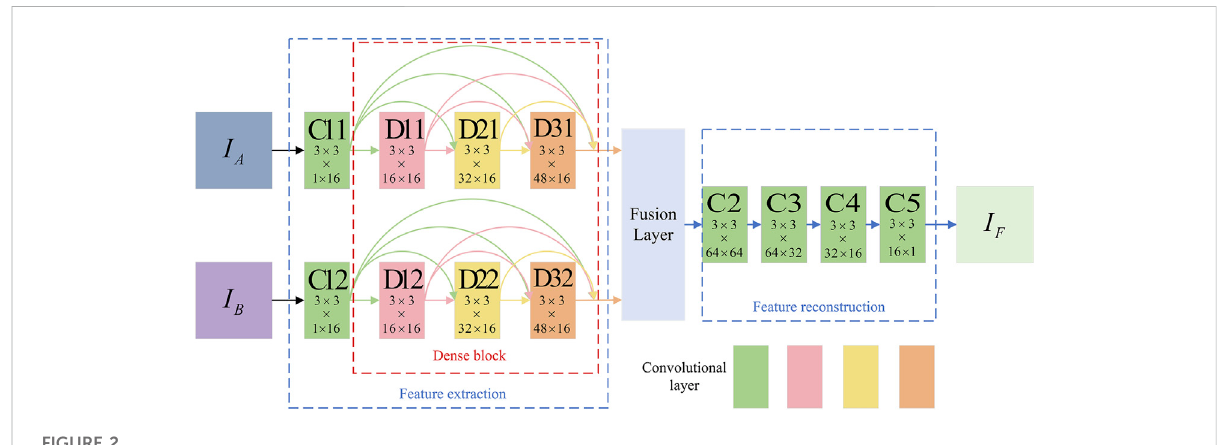
FIGURE 2 The architecture of the proposed